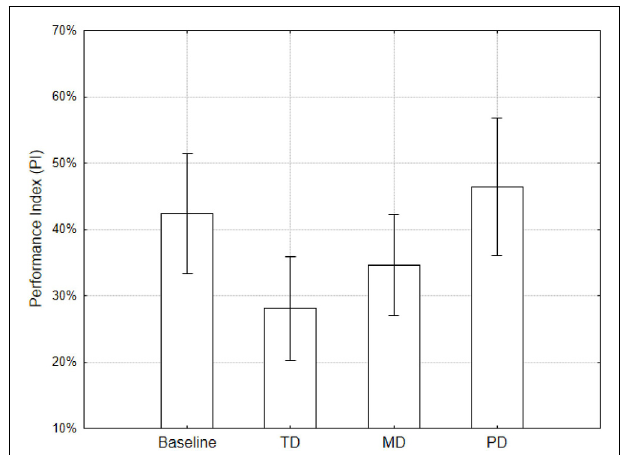
FIGURE 2 | NASA-TLX values (weighted scores) separately for the conditions. Error bars denote 0.95 confidence intervals.